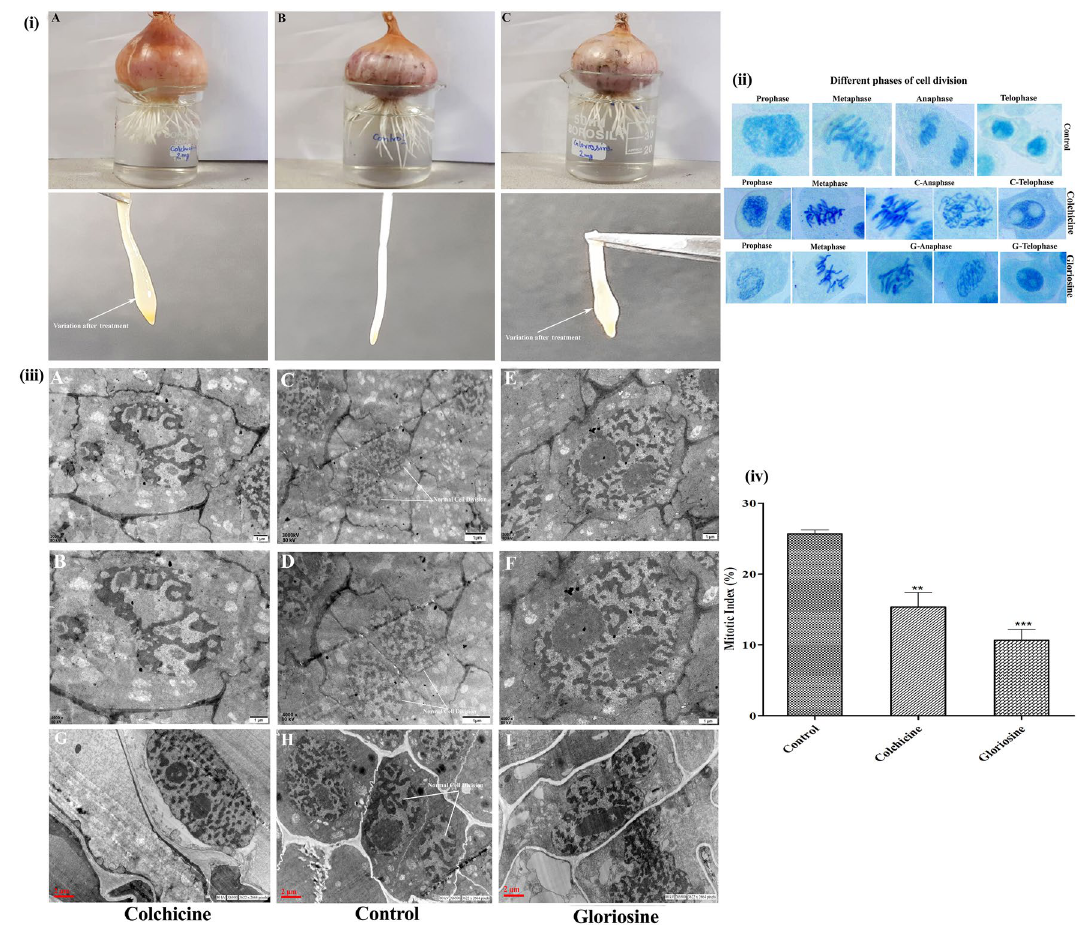
Figure 4. In vivo anti-mitotic and anti-proliferative activity of Iso1 and Iso2. ( i ) Allium cepa root tip growing in Iso1 ( iA ), control ( iB ) and Iso2 ( iC ). ( ii ) Different phases of cell division and anomalies induced by three treatments in onion root tip cell. ( iii ) TEM micrographs representing abnormal cell division in Iso1 treated cells ( iii A,B,G ), control ( iiiC,D,H ) and Iso2 treated ( iiiE,F,I ) cells. ( iv ) Mitotic index (%) of treatment after 24 h at 0.05 mg/ml of colchicine (Iso1) and gloriosine (Iso2) was represented by bars and found significant than control. Two and three asterisk denotes significance of treatment from control at p value of 0.0005 and 0.0001